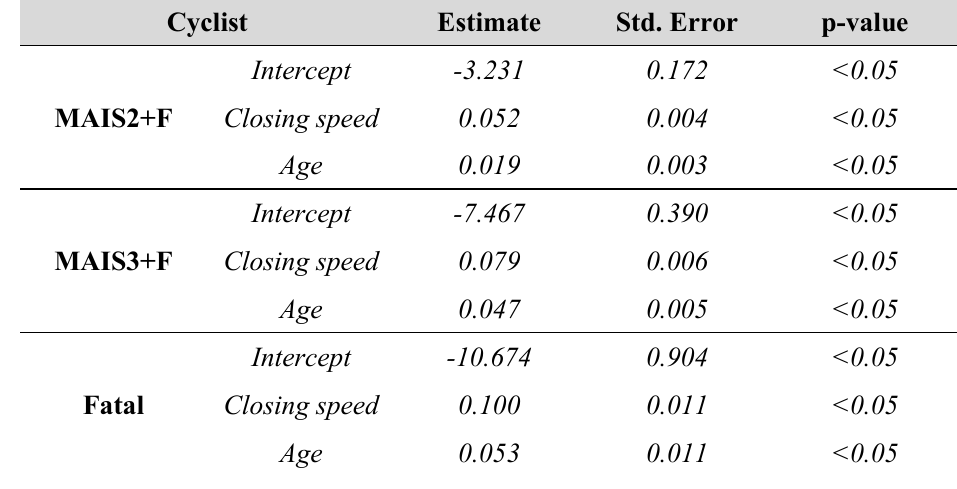
Table 3. Cyclist injury risk models: Logistic regression coefficient estimates according to Equation (1)